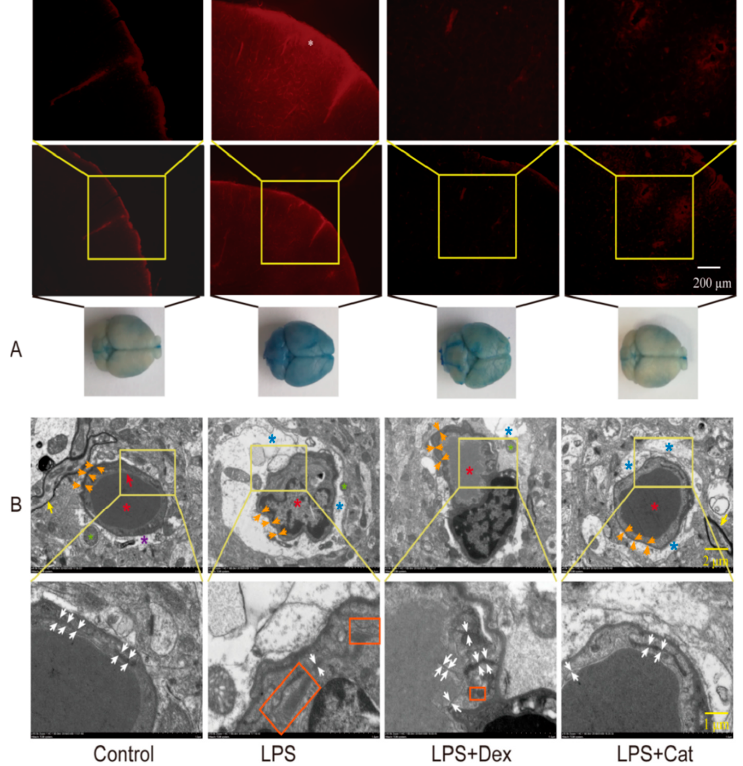
Figure 3. Catalpol improved LPS-induced BBB damage. ( A ) EB leakage in brain tissue. *, the cerebral cortex was filled with robust fluorescent signals. ( B ) the ultrastructural changes of the BBB. Red asterisks indicate the vessel; Red arrows indicate the endothelial cells; Orange arrows indicate the basal lamina; Purple asterisks indicate the astroglial end feet; Green asterisks indicate the axon or dendrite; Yellow arrows indicate the myelin sheath; Blue asterisks indicate the swollen astroglial end feet; White arrows indicate the tight junction; Red panels indicate the detached tight junction. LPS, mice given a series intraperitoneal injection of 5 mg/kg LPS dissolved in sterile normal saline at 0, 12, 24 h. LPS + Dex, mice were given 40 µ g/kg dexamethasone 30 min after the first dose of LPS. LPS + Cat. Before administration of LPS, mice were given intraperitoneal injection of 5 mg/kg catalpol, once a day for three